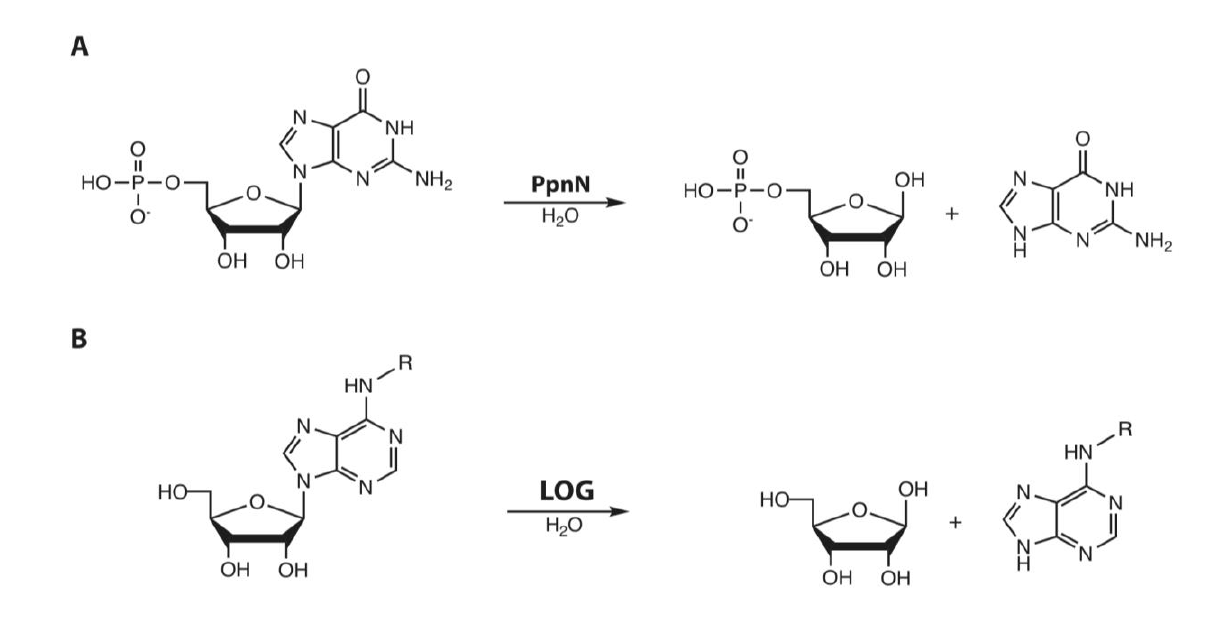
FIGURE 1 : Reactions carried out by PpnN and LOG proteins, respectively. (A) PpnN hydrolyses 5'-monophosphate nucleotides at the glycosid- ic bond to yield ribose-5-phosphate and free nucleobase. (B) LOG proteins activate cytokinin-type plant hormones by releasing a modified adenine from